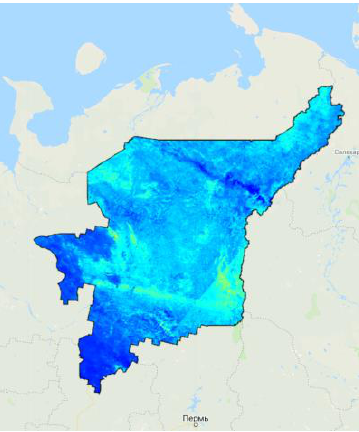
Figure 1. NDWI map for the republic of Komi (2000-03-01)